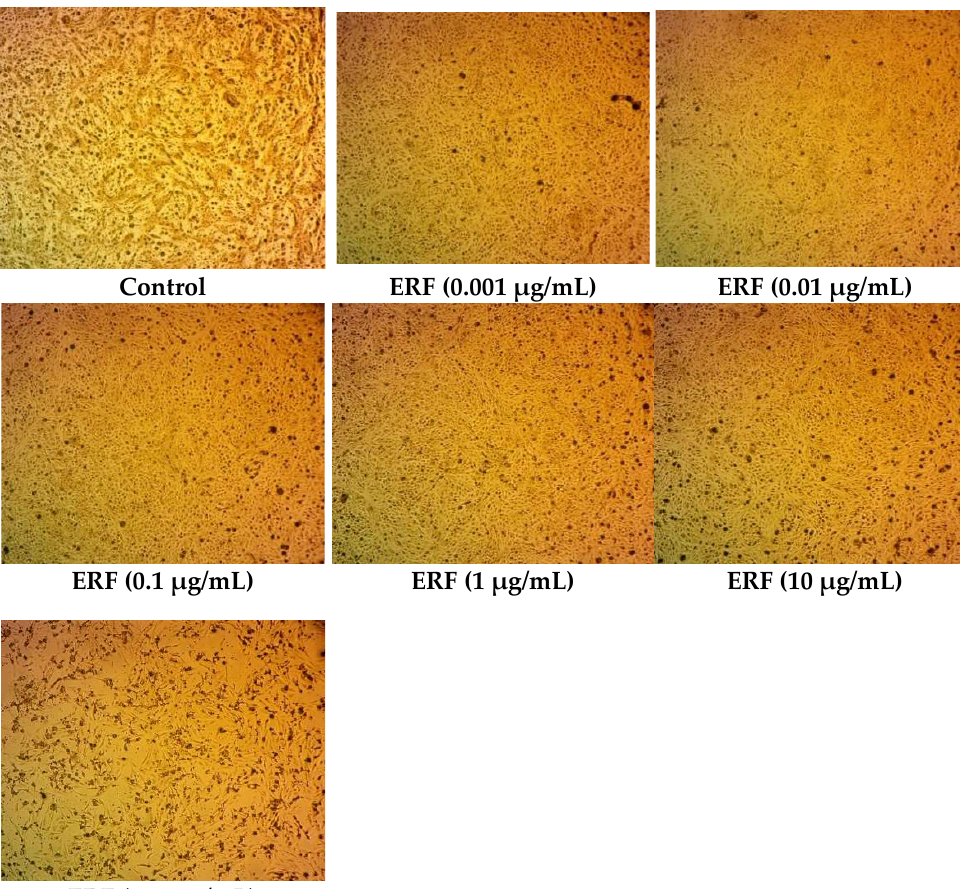
Figure 7. Photomicrographs of HepG2 cells treated with ERF (100× magnification).